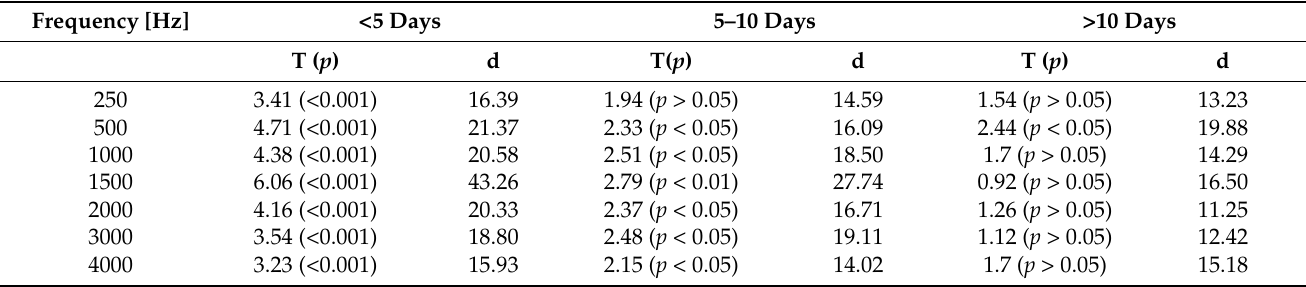
Table 3. The delay in implementing ST and improvement of hearing in patients with